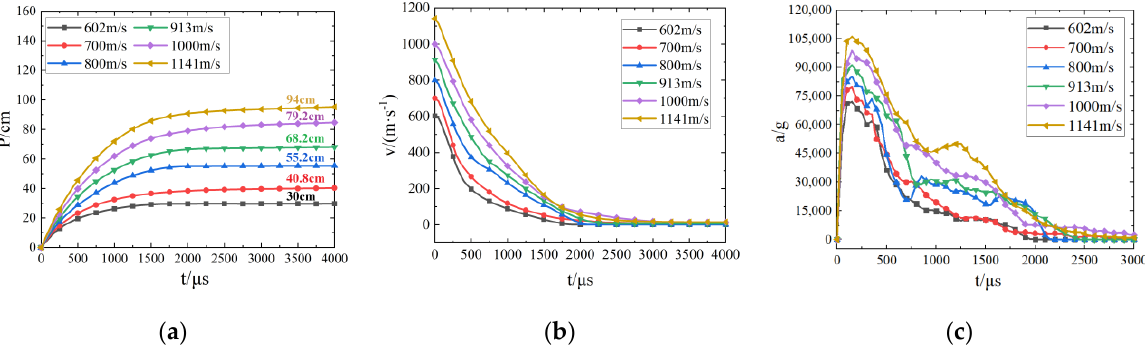
Figure 12. Data of projectile penetration into limestone target: ( a ) penetration depth versus time curve; ( b ) penetration velocity versus time curve; ( c ) penetration acceleration versus time curve.